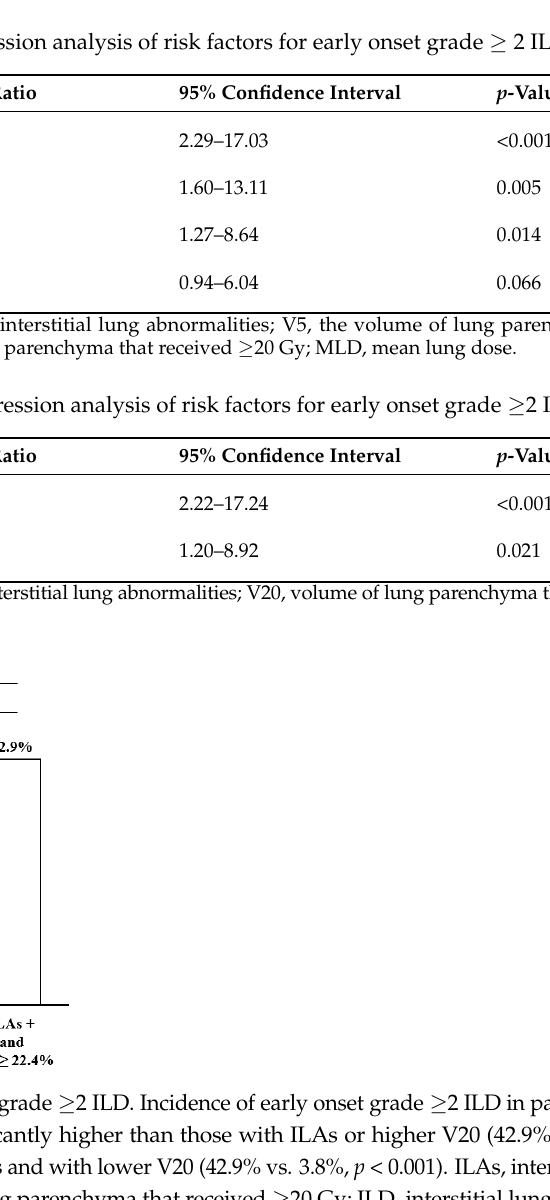
Figure 3. Kaplan–Meier analysis of time to onset of grade ≥ 2 ILD between patients with ILAs and higher V20, with ILAs or higher V20, and without ILAs and with lower V20. The time to onset of early onset grade ≥ 2 ILD was significantly shorter in the group with ILAs and higher V20 compared to the group with ILAs or higher V20, log-rank test p < 0.001; the group without ILAs and with lower V20, log-rank test p < 0.001. ILAs, interstitial lung abnormalities; V20, volume of lung parenchyma that received ≥ 20 Gy; ILD, interstitial lung disease. 4. Discussion In this study, the multivariate logistic regression analysis revealed that V20 and ILAs, especially GGA, were independent risk factors for grade ≥ 2 ILD. To the best of our knowledge, this is the first study to show that pre-existing ILAs are independent risk fac- tors for grade ≥ 2 ILD during durvalumab treatment. Previous studies showed that the